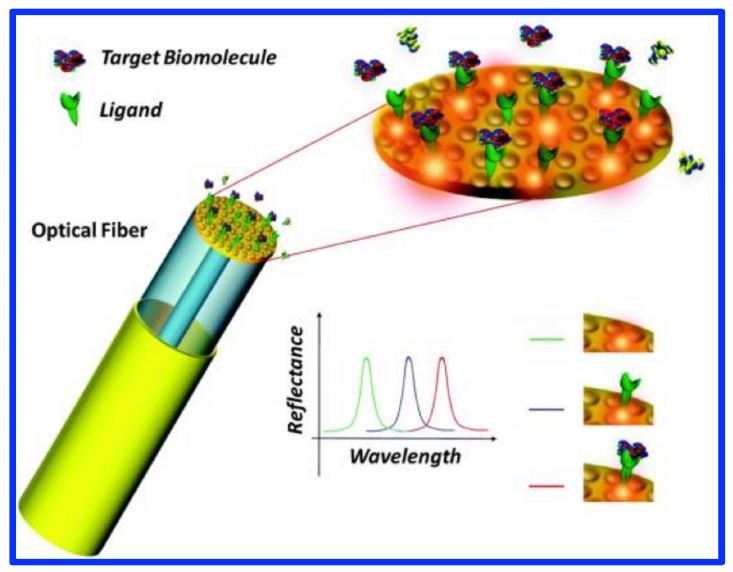
Figure 5. Distal type sensors. Adapted with permission from [37] Copyright 2015 © Royal Society of